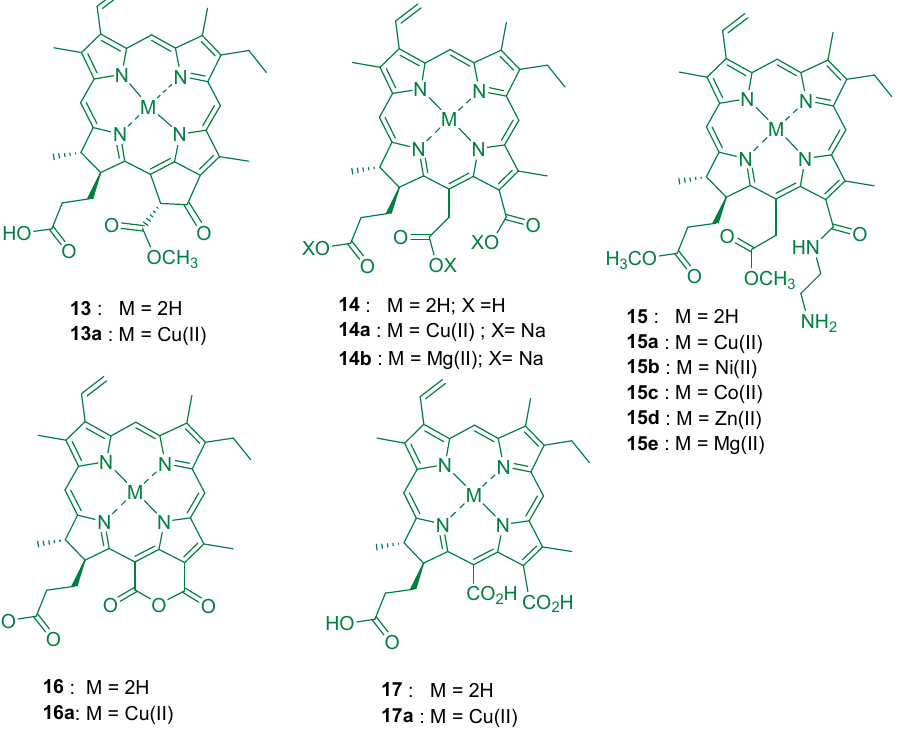
Figure 11. Structure of pheophorbide- a ( 13 ) chlorin e 6 ( 14 ), 6- N -(2-aminoethylamido)chlorin e 6 dimethyl ester ( 15 ) purpurin 18 ( 16 ) and chlorin p 6 , ( 17 ) and some metal complexes.